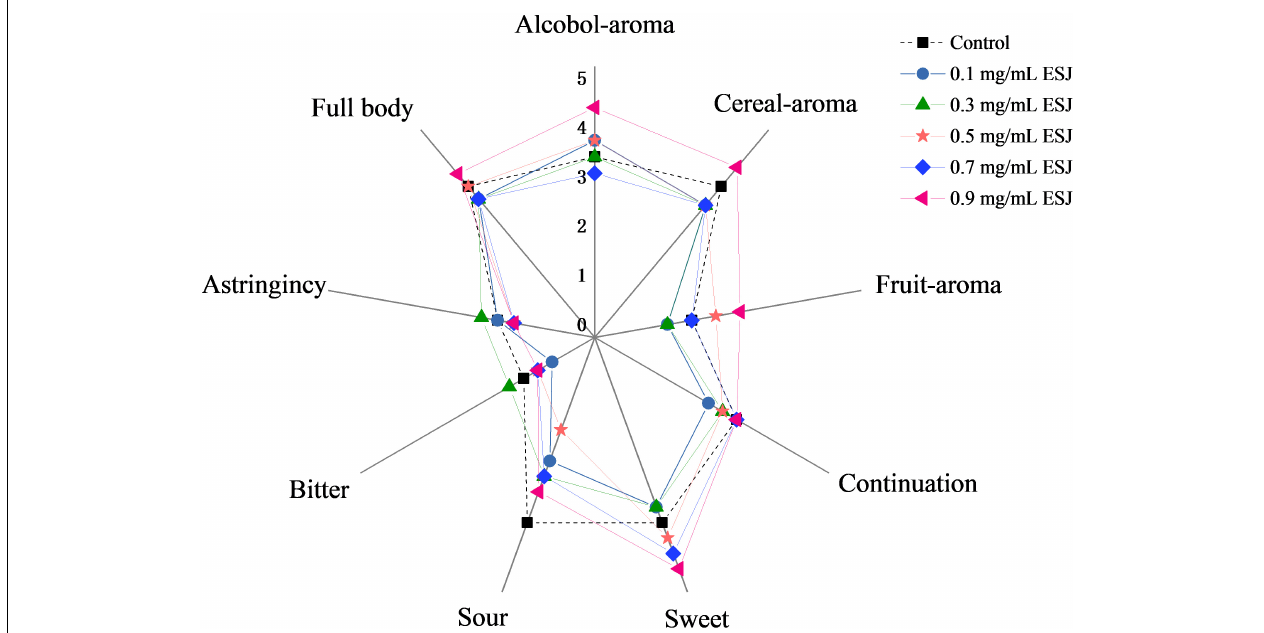
FIGURE 5 | Scores of sensorial attributes for HQW treated with different concentrations of FSI after sterilization and aged for 160 days.